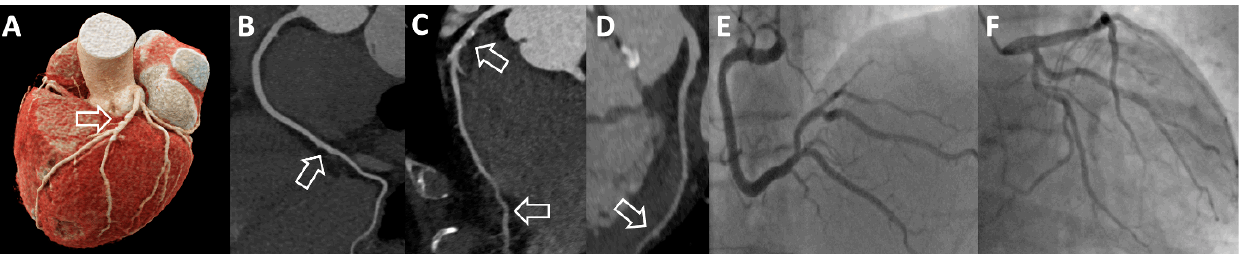
Figure 1. Evaluation of an 81-year-old male patient with severe AS prior to TAVI. Retrospective ECG gating was used as the CT acquisition technique and provided excellent image quality. As shown by the three-dimensional volume rendering ( A ), as well as the vessel views of the dominant right coronary artery ( B ), left anterior descending coronary artery ( C ) and left circum fl ex coronary artery ( D ), only minimal stenosis (1–24% luminal diameter stenosis; CAD–RADS 1; white arrows) was found. ICA of the right ( E ) and left coronary artery ( F ) was redundant and con fi rmed absence of relevant CAD.